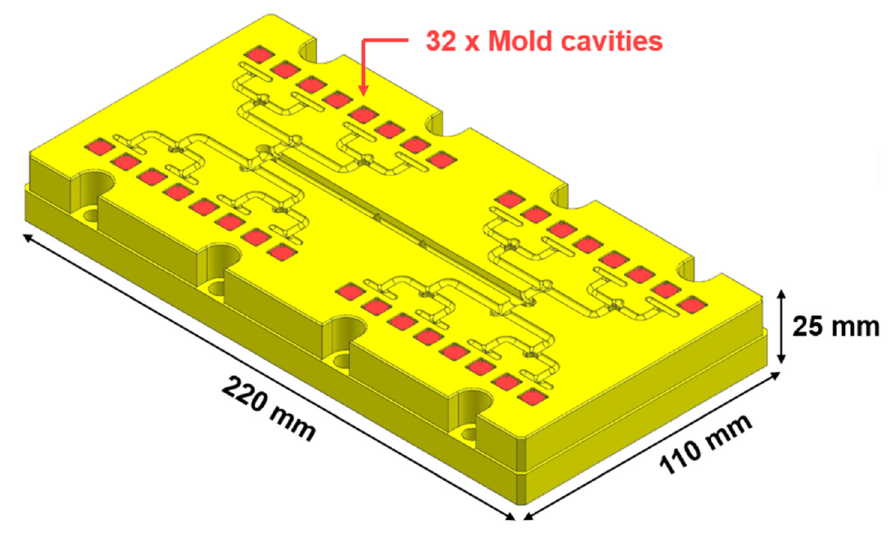
Figure 1. Mold insert for plastic injection molding (adapted with permission from from [26]).